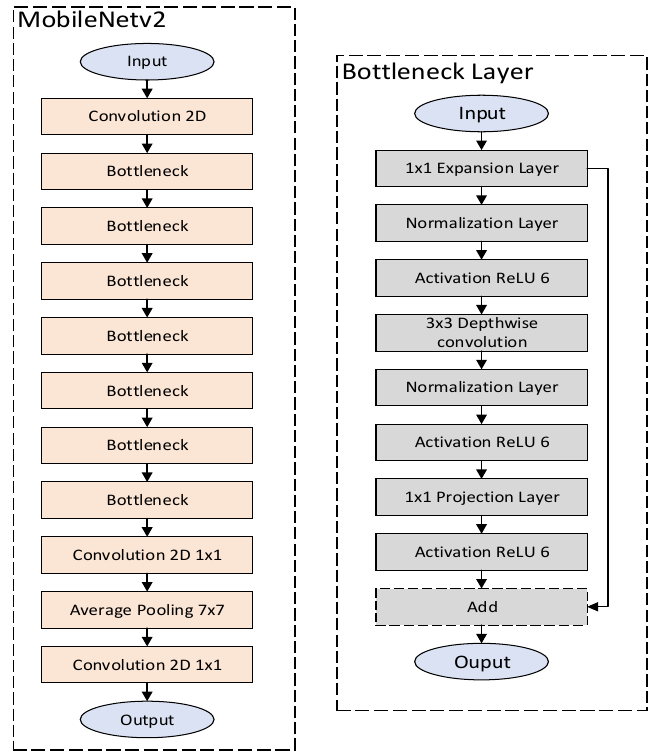
Figure 1. The architecture of MobileNetV2